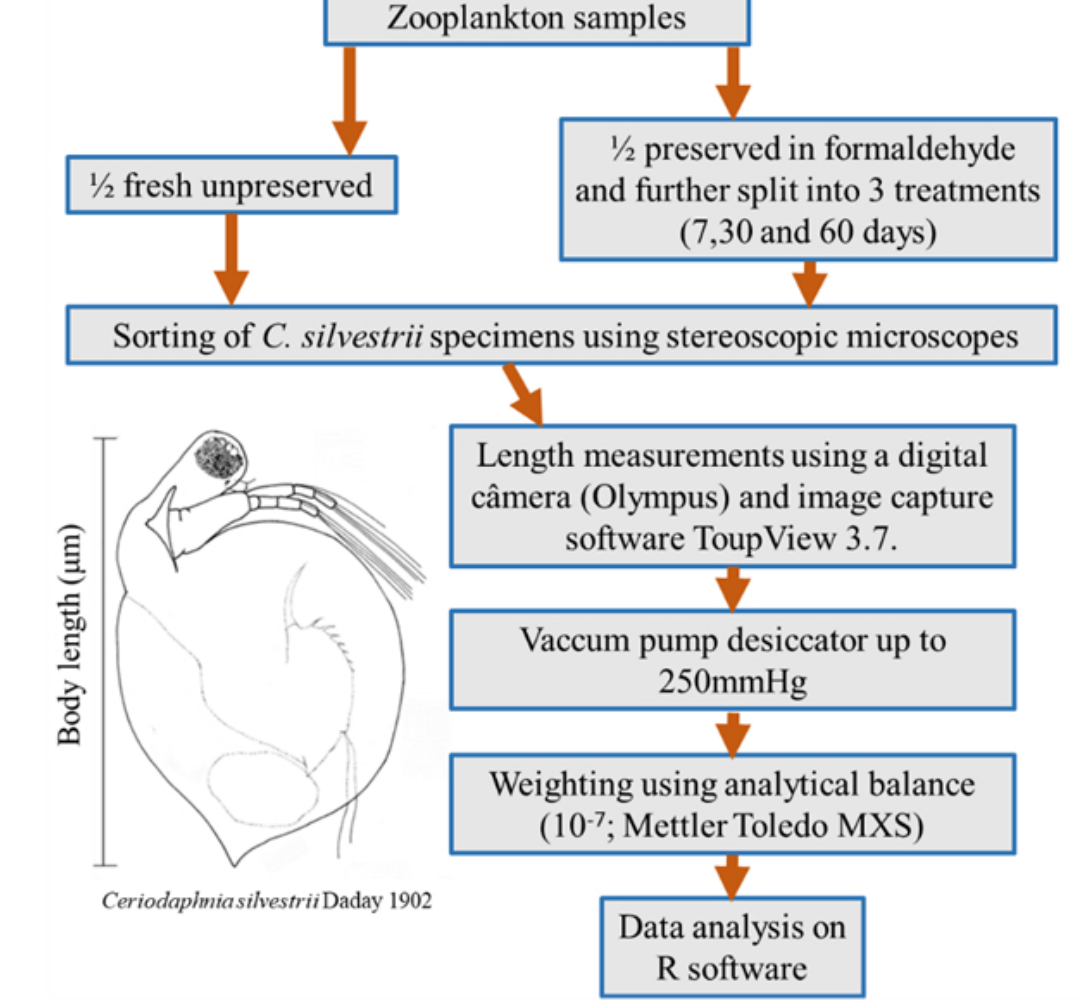
Figure 1. Work flow chart showing the methodological steps of the experimental